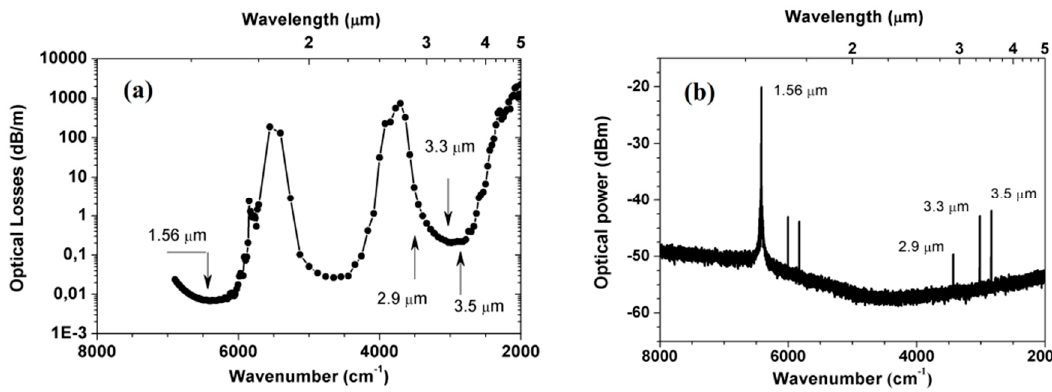
Figure 12. ( a ) Calculatedspectrum of optical losses for RF that was developed in [59,60] to realize Raman gas fiber lasers (GFL) for 2.9–3.5 μ m spectral region; ( b ) Output spectrum of the Raman gas fiber laser [60]. Peak pump power at λ = 1.56 μ m coupled into the RF was 14 kW. A mixture of light hydrogen and deuterium at partial pressures of 2 and 28 atm, respectively, was used as an active medium.